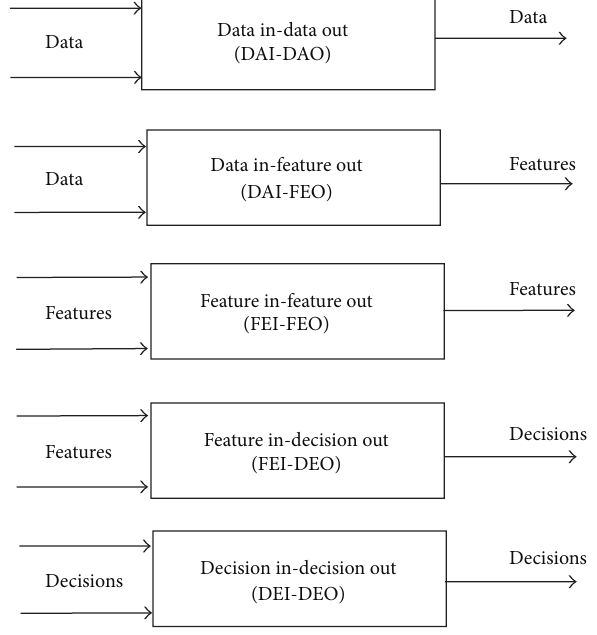
Figure 2: Dasarathy’s